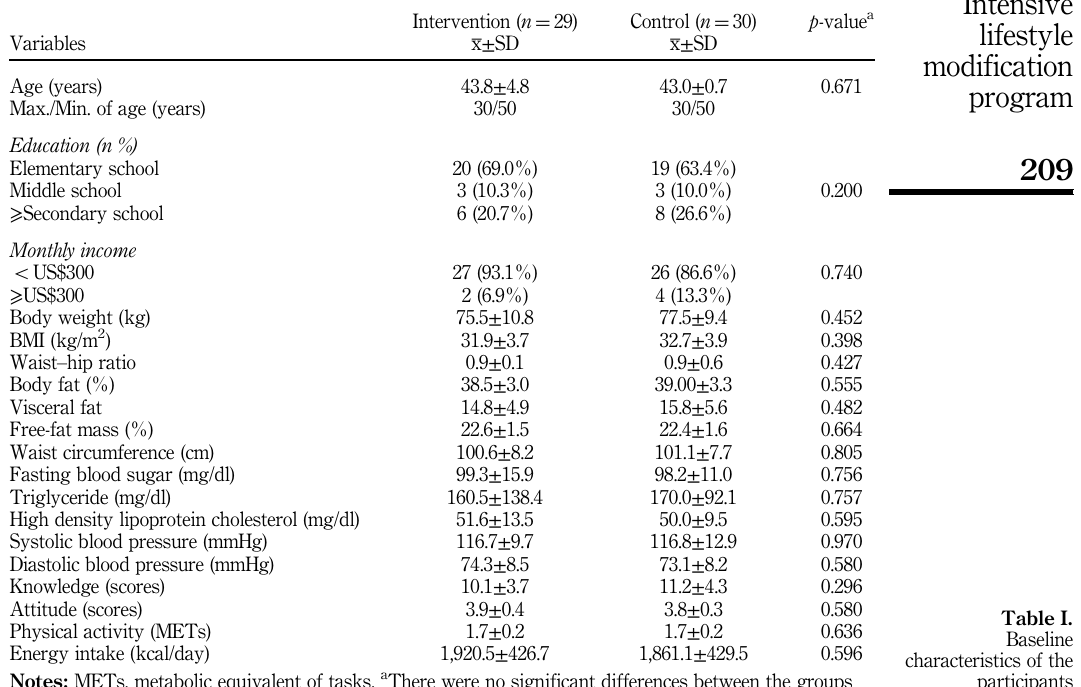
characteristics of the